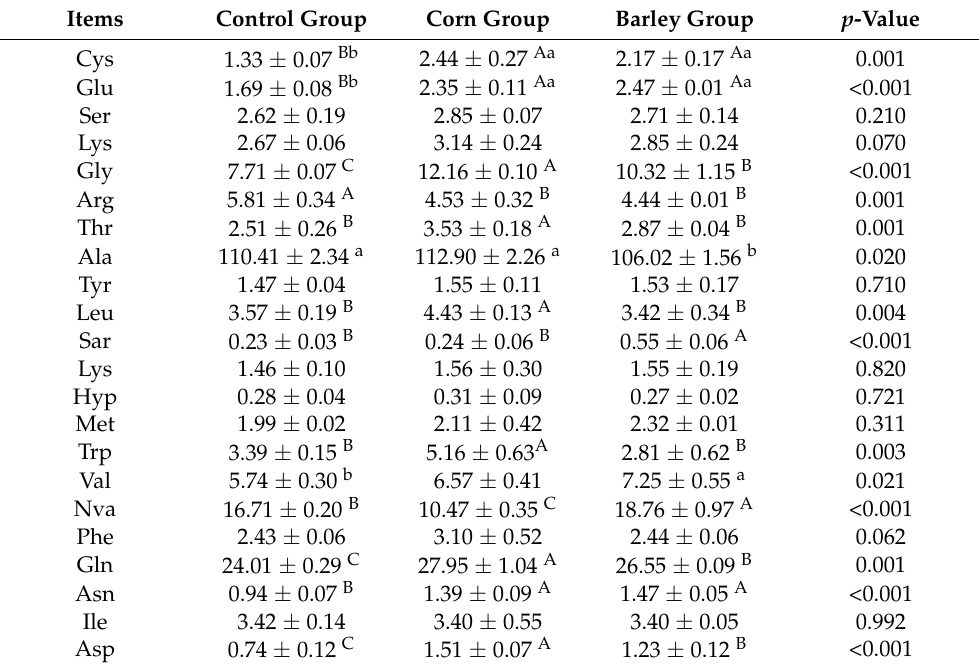
Table 8. Effects of different carbohydrate source diets on content of free amino acids (mg/100 g) 518 in